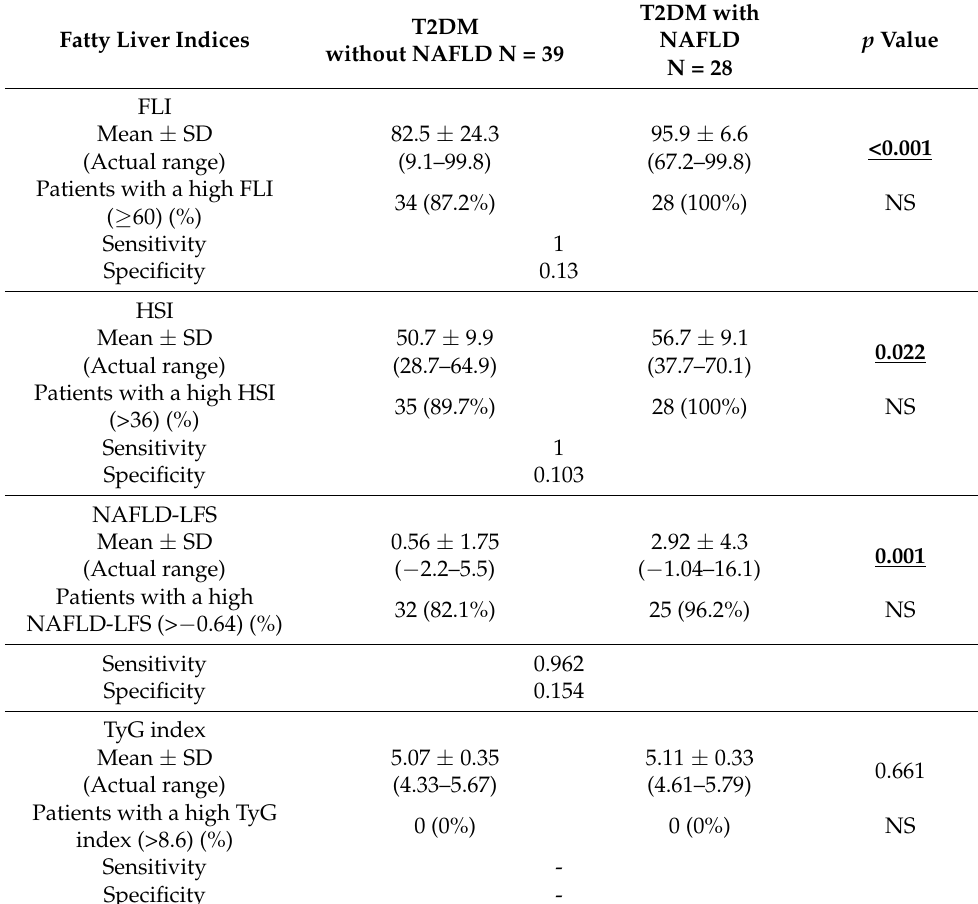
Table 4. Mean ± SD of fatty liver indices in T2DM patients with and without NAFLD, and the number of patients with high values of the indices.